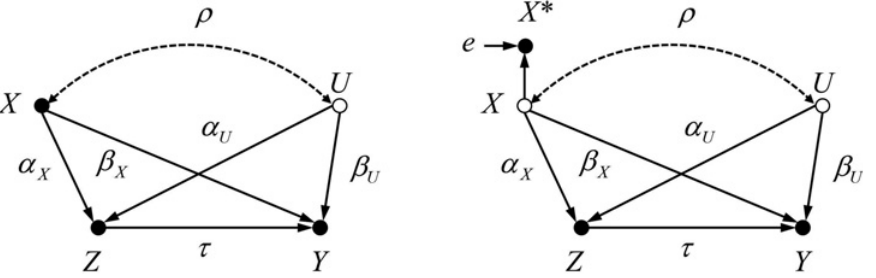
Figure 4: Causal graphs with two correlated confounders X and U , with X reliably measured in the left graph and X measured with error in the right